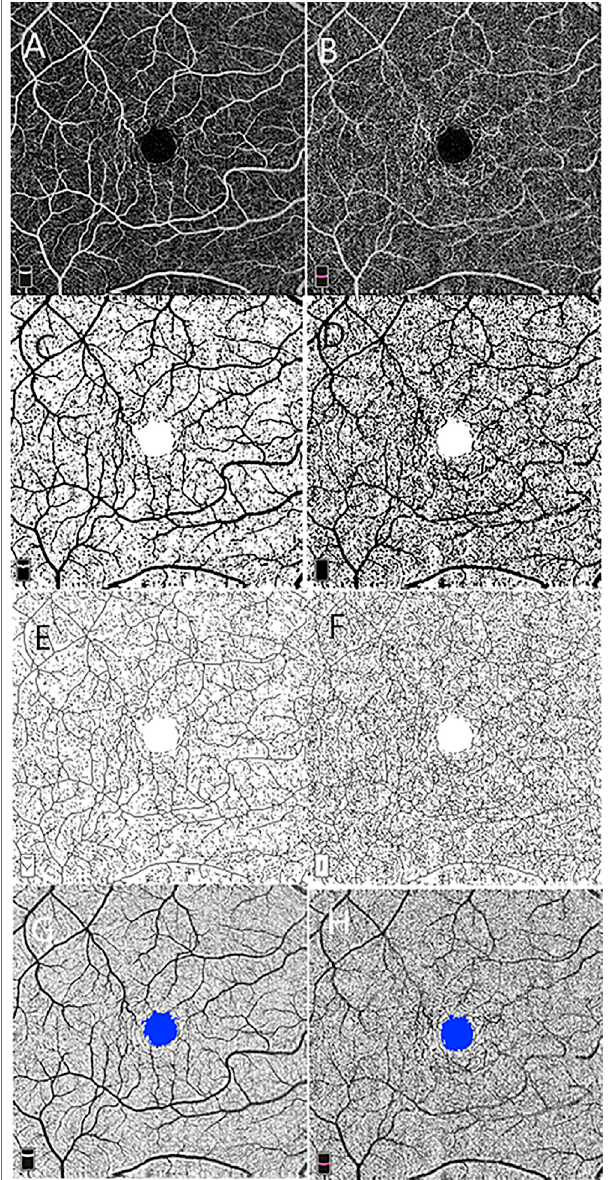
FIGURE1| Macularvasculardensitymeasurementandfovealavascular zone (FAZ) analysis using 6 × 6 mm optical coherence tomography angiographyscancenteredonthemaculaatthelevelofthesuper fi cial (A) and deep (B) retinal vascular networks. Vascular density is measured in the entire contrast-enhanced binarized images of the super fi cial (C) and deep (D) retinalvascularlayer.Skeletondensity iscalculatedintheskeletonizedimages of the super fi cial (E) and deep (F) networks. The FAZ is shown on the super fi cial (G) and deep (H) networks.